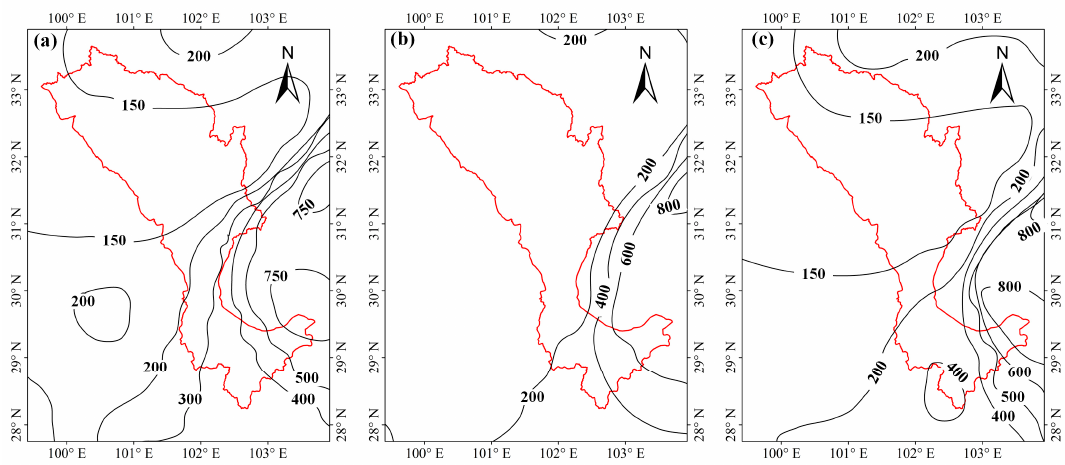
Figure 10. Comparison with historical studies: ( a ) comparison with WMO (2009); ( b ) comparison with Wang (1987); and, ( c ) comparison with Wang (1999).